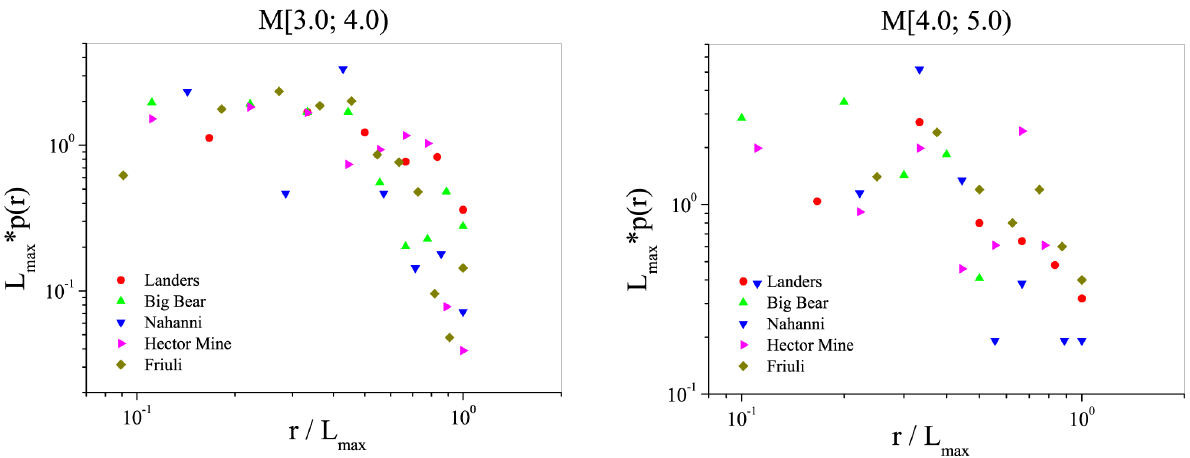
* P ( r ) – r main shock-aftershock distance, for the selected earthquakes ; y = L max max